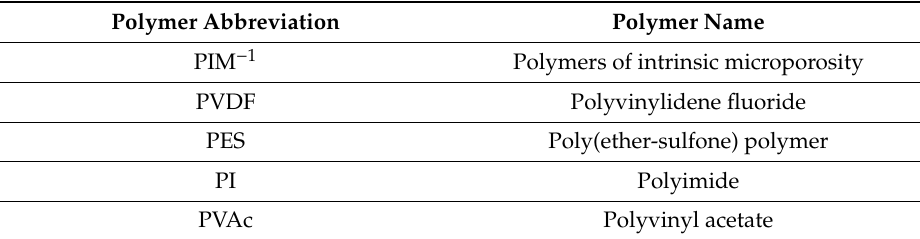
Table 3. Names and abbreviations of the polymers used in this